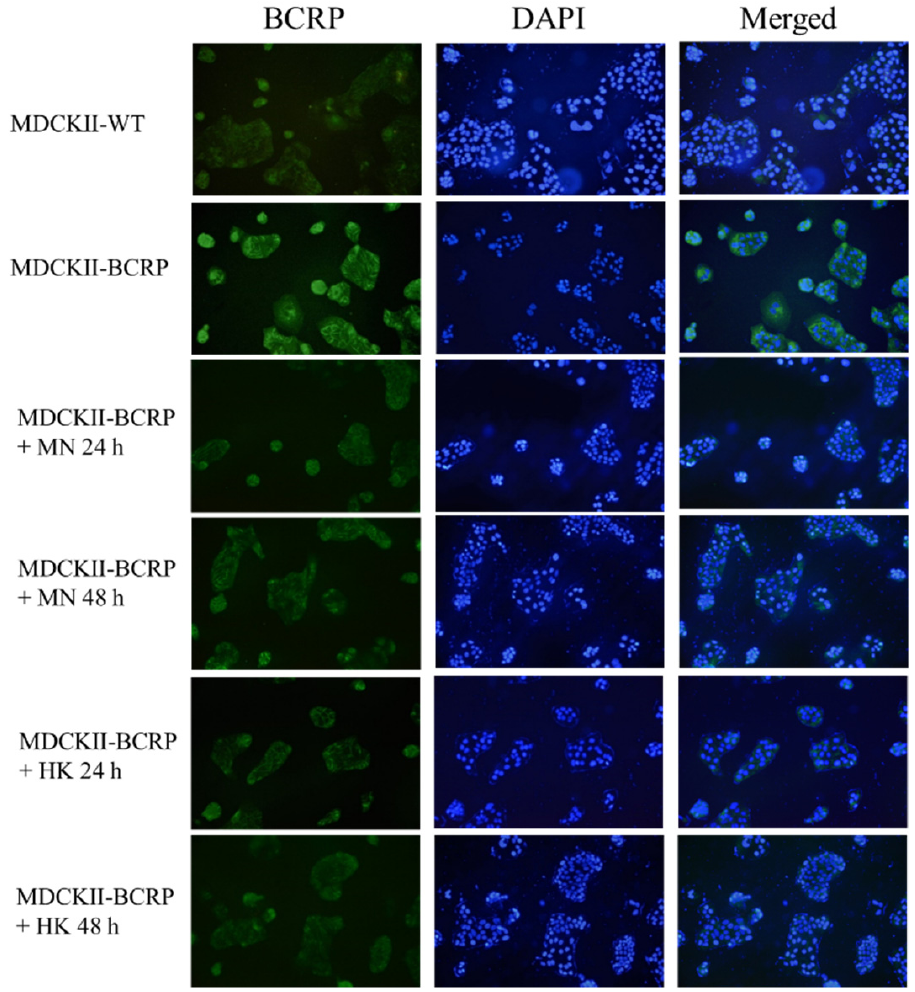
Figure 4. Effects of MN (12.5 µM) and HK (12.5 µM) on the protein expression of breast cancer resistance protein (BCRP) in MDCKII-WT and MDCKII-BCRP cells at 24 h and 48 h after incubation. On other hand, through western blot analysis, the protein expressions of p-EGFR, p-PI3K and BCRP in MDCKII-BCRP cells after treating with MN and HK, individually, for 24 h and 48 h are shown in Figure 5. The results showed that after treatment with MN and HK for 48 h, the protein expressions of p-EGFR were significantly reduced by 12% and 25%, the protein expressions of p-PI3K were significantly decreased by 14% and 41%, and the protein expressions of BCRP were significantly reduced by 47% and 17%, respectively, indicaing that MN and HK decreased the expressions of p-EGFR, p- PI3K and BCRP. Moreover, Figure 5 also showed that the modulation effects were in a time-dependent